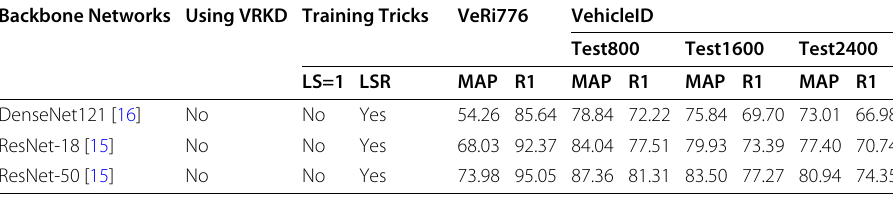
Table 2 The accuracy performance (%) of three backbone networks on the VeRi776 [1] dataset and the VehicleID [2]